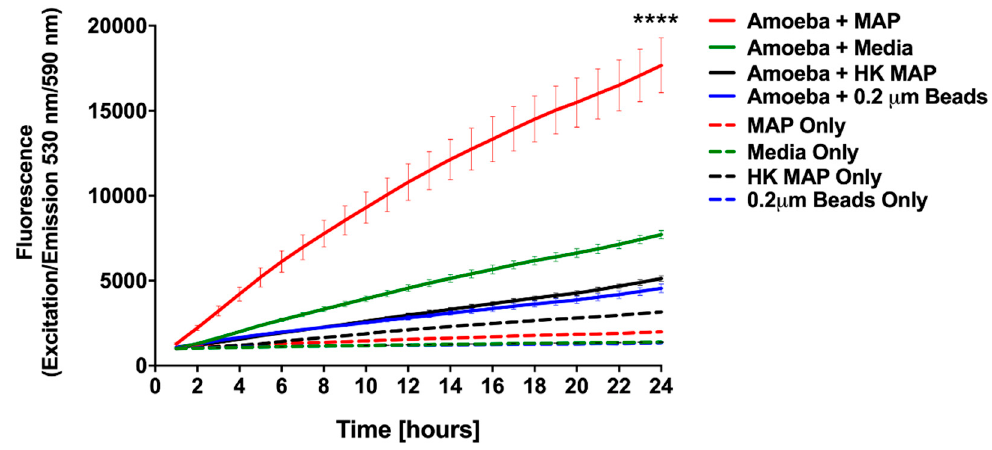
Figure 3. Stimulation of amoeba metabolism by MAP infection. Amoeba was infected with either live or heat-killed MAP (MOI 10). The 0.2 μ m latex beads and no infection (PYG medium alone) served as controls. Plates were incubated for 1 h at 25 °C, and then extracellular bacteria, debris, or beads were removed by washing. Wells were replenished with fresh PYG medium containing 10% alamarBlue and fluorescence was measured at 530 nm/590 nm every hour for 24 h. Data represent the mean ± SD of two independent experiments conducted in triplicate. **** p -value < 0.0001 between live MAP-infected and all control groups at 24 h time point. HK, heat killed MAP.